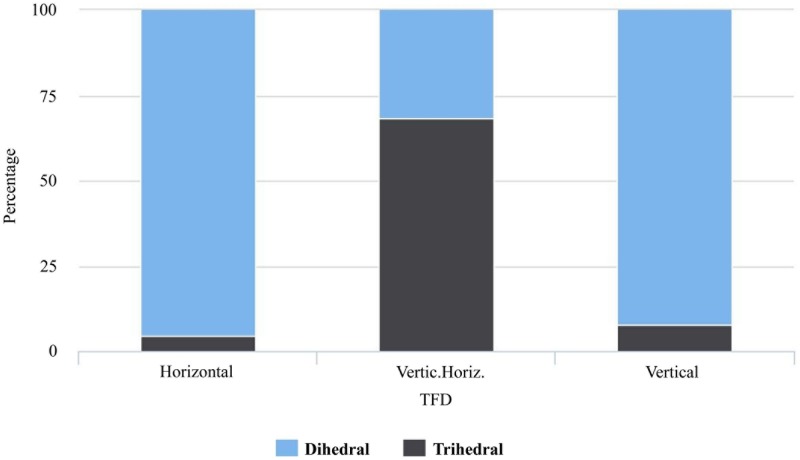
Tool functioning direction (TFD) and dihedral geometry.Bar plot of TFD grouped by geometry.